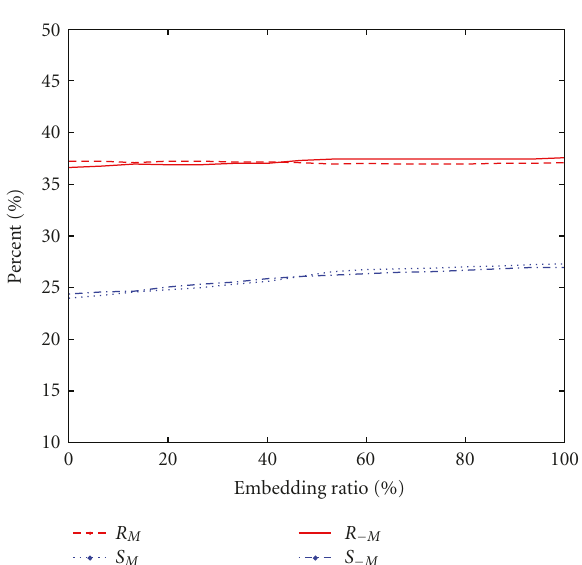
Figure 13: RS-diagram of Lena stego image.